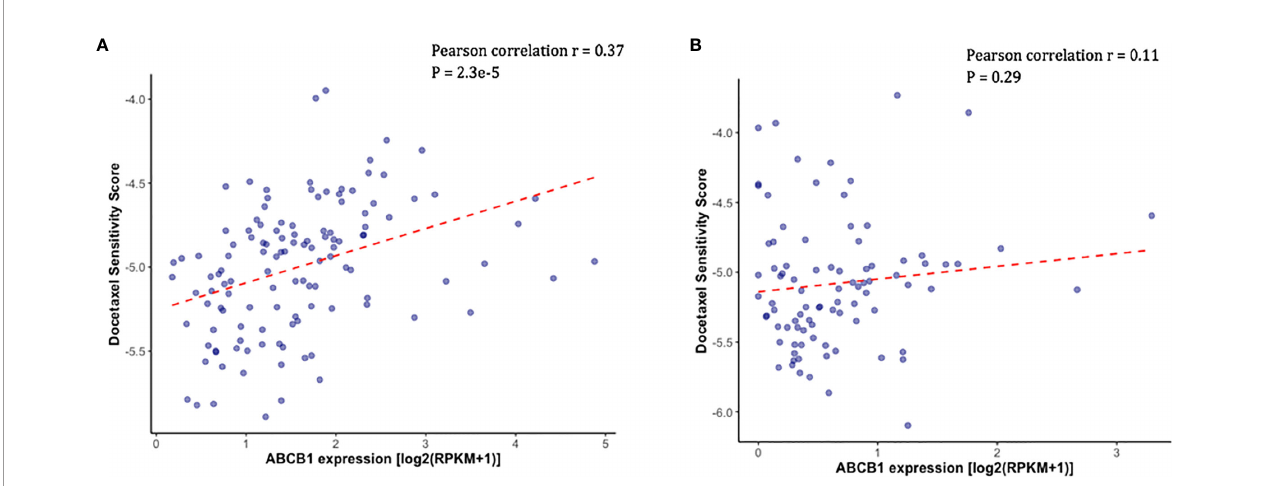
FIGURE 5 | Higher measured ABCB1 expression was correlated with higher predicted docetaxel sensitivity score (indicating lower sensitivity to docetaxel) in two CRPC trials. (A) Scatter plot showing the predicted docetaxel sensitivity score (Y-axis) and the expression level of ABCB1 (X-axis) in PCa patients in SU2C trial. (B) Scatter plot showing the predicted docetaxel sensitivity score (Y-axis) and the expression level of ABCB1 (X-axis) in PCa patients in PROMOTE